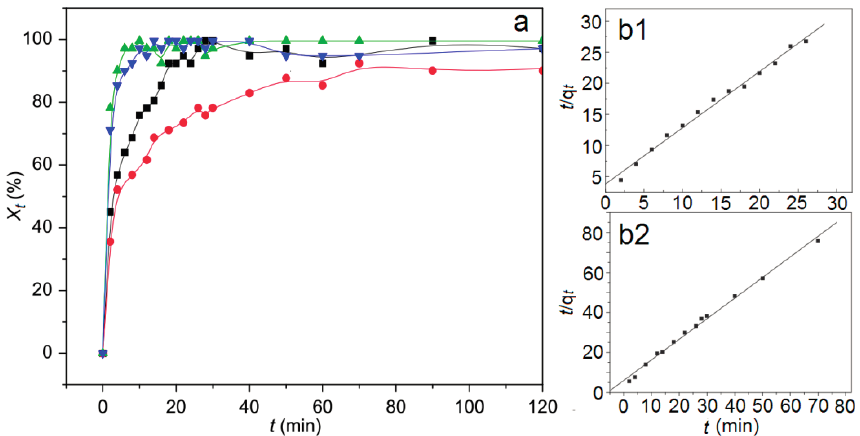
Figure 18. Release profiles ( a ) for CPT from a CPT–LDH composite and the physical mixture at pH 4.8 and pH 7.2 ( ■ : composite, pH 4.8; ● : composite, pH 7.2; ▲ : physical mixture, pH 4.8; ▼ : physical mixture, pH 7.2) and linear regression curves of release data fitted with the pseudo-second-order kinetic model at pH 4.8 ( b1 ) and pH 7.2 ( b2 ) ( t refers to release time, X refers to percentage releases, q refers to release amount at any time ( t )). t t Modified with permission from [99] (Copyright 2010